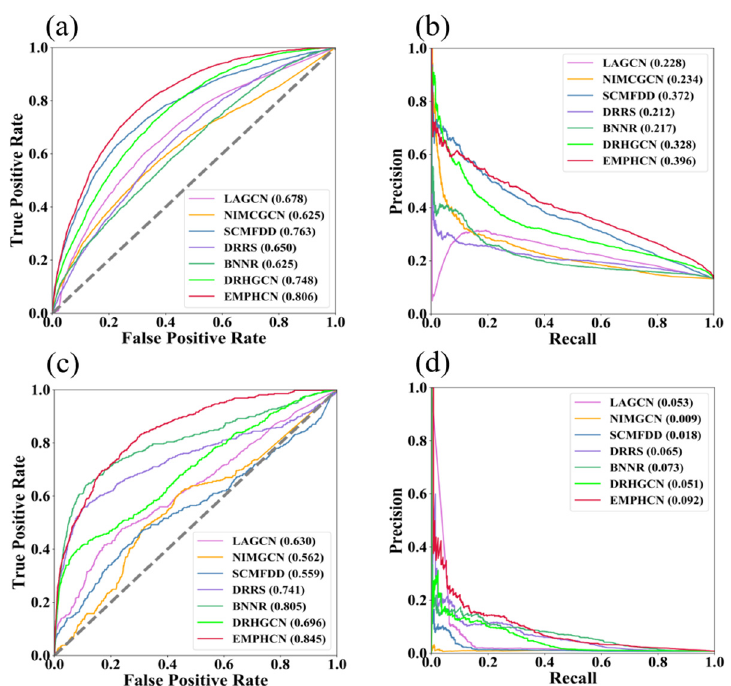
Figure 8. Comparison of novel prediction results with different methods. ( a ) ROC curve comparison of various methods on the T1 dataset. ( b ) PR curve comparison of various methods on the T1 dataset. ( c ) ROC curve comparison of various methods on the T2 dataset. ( d ) PR curve comparison of various methods on the T2 dataset.